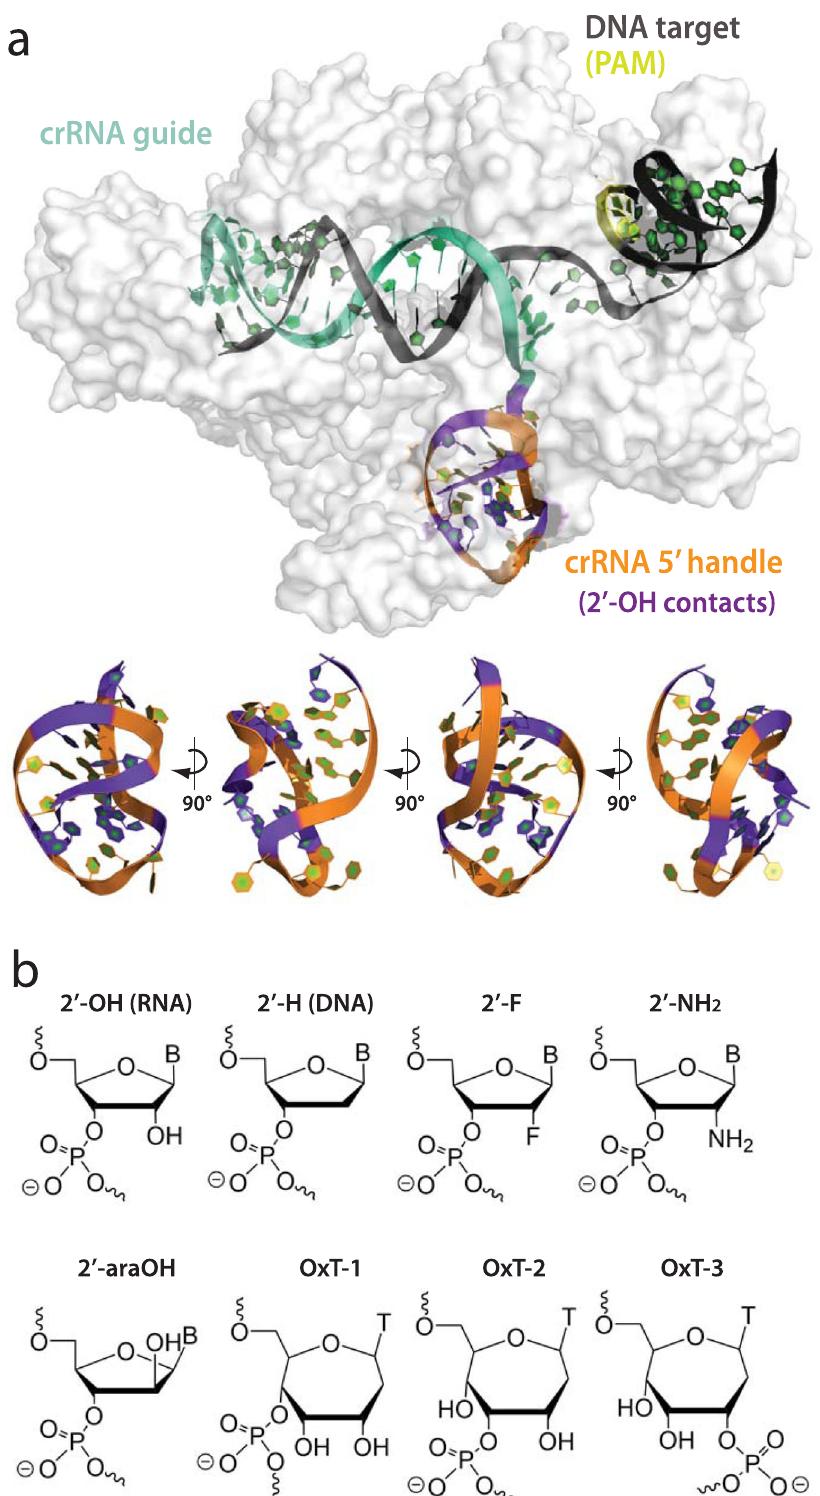
Fig. 1 Structural overview of AsCas12a ribonucleoprotein complex, the crRNA 5 ′ pseudoknot, and chemical modi fi cations incorporated into the pseudoknot. a As Cas12a 5 ′ handle pseudoknot structure (PDB ID 5B43). Cas12a protein is rendered as a surface (light gray), DNA target as dark gray, PAM sequence in yellow, crRNA guide in teal, 5 ′ handle in orange, and 5 ′ handle nucleotides that make 2 ′ -OH polar contacts within the structure in purple. b Chemically modi fi ed ribose analogs and substitutes used in this